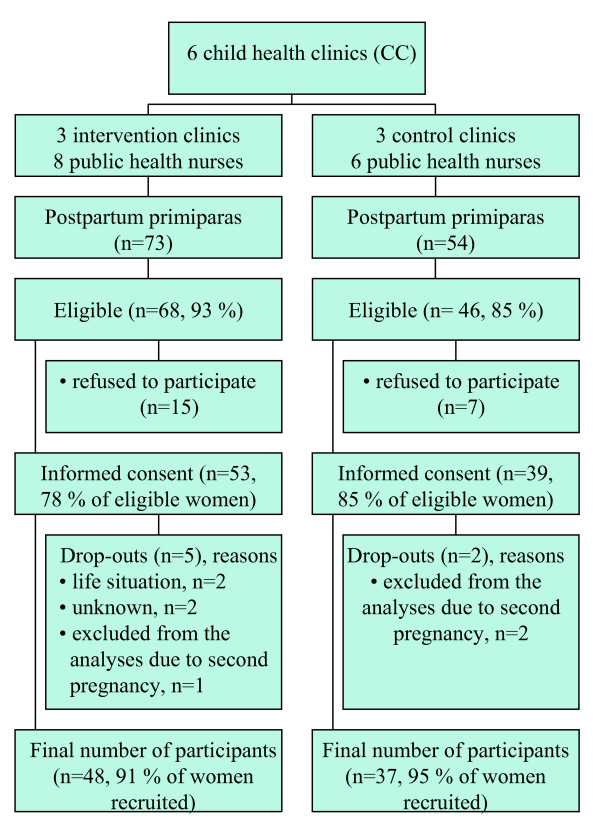
Participant flow.